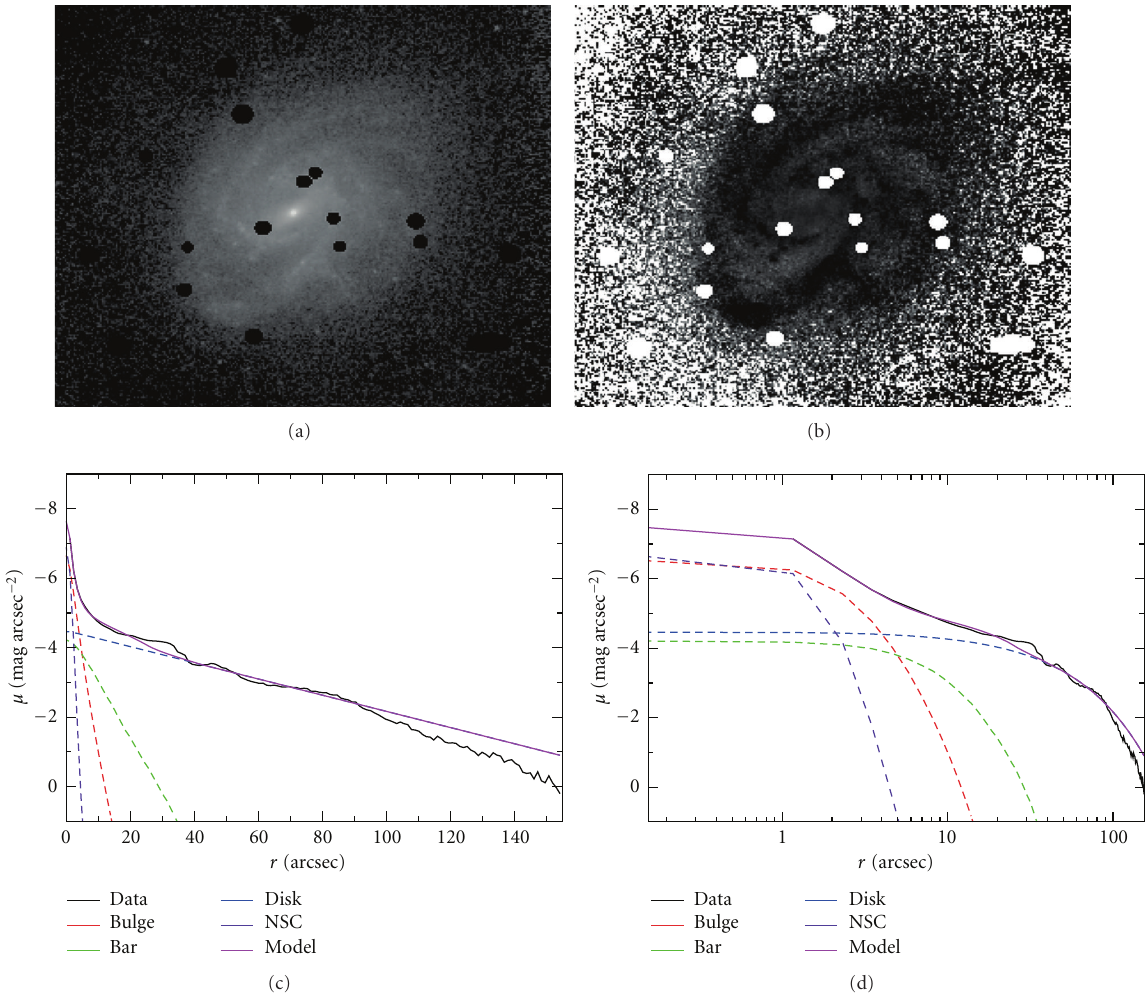
Figure 1: An example of one of our 2D decompositions of NSC host galaxies—in this instance, the decomposition of the OSU BSGS H -band image of NGC 7418, using an exponential disk, a S´ersic bulge ( n = 1 . 5), a bar, and a point source for the NSC. (a): original H -band image, with masking of bright stars (logarithmic brightness scaling). (b): residual image after subtracting best-fitting model image. (c): major-axis profile (black) along with the components of the model and their sum (purple). (d): same, but plotted with logarithmic major-axis